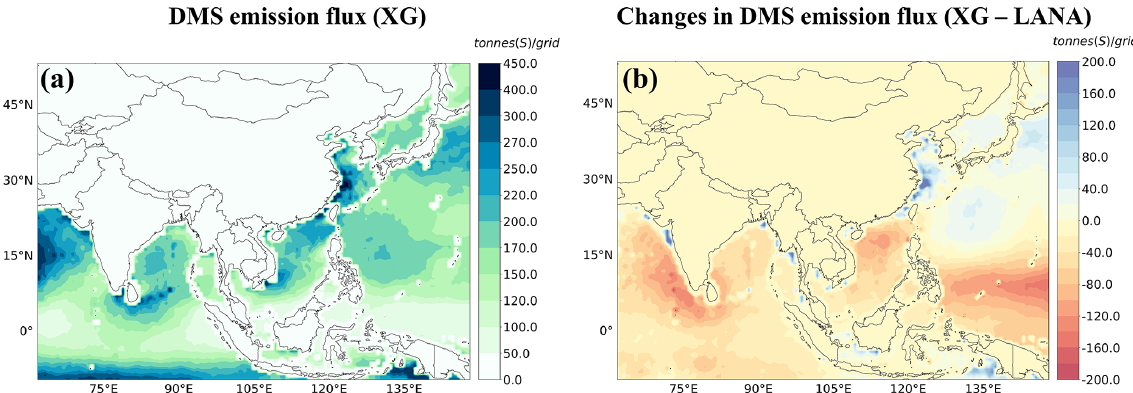
Figure 3. Panel (a) presents annual DMS emission flux calculated based on N00 flux parameterization (Nightingale et al., 2000) from XG sea surface concentrations. Panel (b) presents changes between DMS emission flux from updated (XG) and default climatology (LANA).